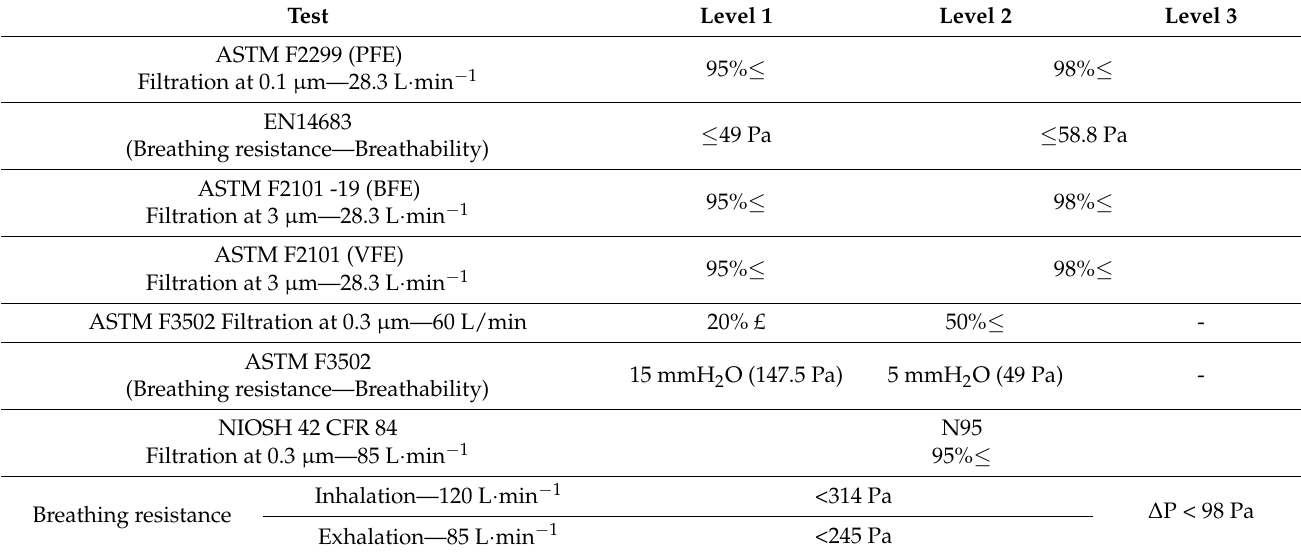
Table 1. Filtration test method